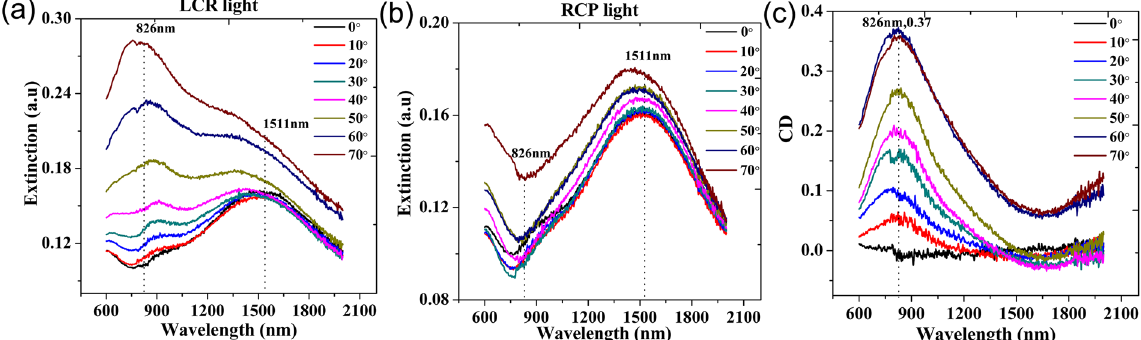
Figure 5. Experimental results of the nanocrescents ( a ) The extinction spectra of metal nanocrescents for LCP light with the increase of θ . ( b ) The extinction spectra of metal nanocrescents for RCP light with the increase of θ . ( c ) The calculated CD of metal nanocrescents with the increase of θ by experiment.